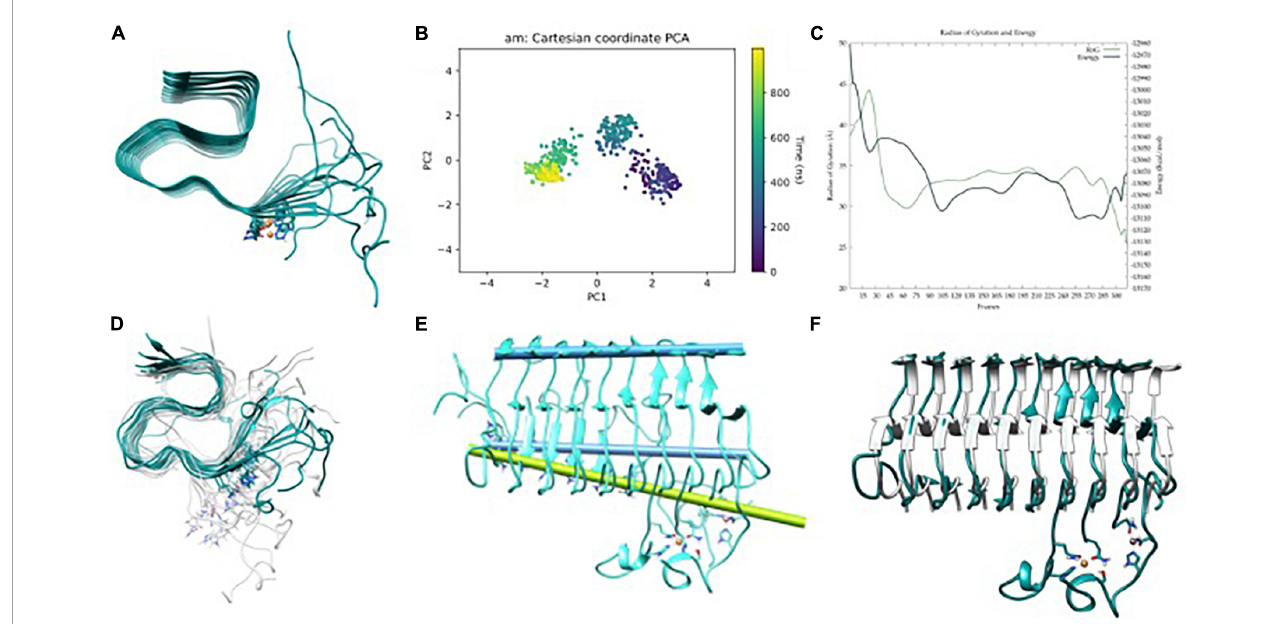
FIGURE4 (A) A β 42 -Cu(II) model, (B) principle component analysis (PCA) of Gaussian accelerated molecular dynamics (GaMD) simulation, (C) energy profile and radius of gyration (RoG) along the GaMD simulation, (D) overlap of representative structures of most populated clusters obtained from GaMD simulations, (E) in blue, axis representation of 39–41 residues (top) and 13–16 β -sheets (bottom); in green; 13–16 β -sheets axis of NMR-structure, and (F) overlap between the solid-state NMR (ss-NMR) structure and the lowest energy structure of the GaMD